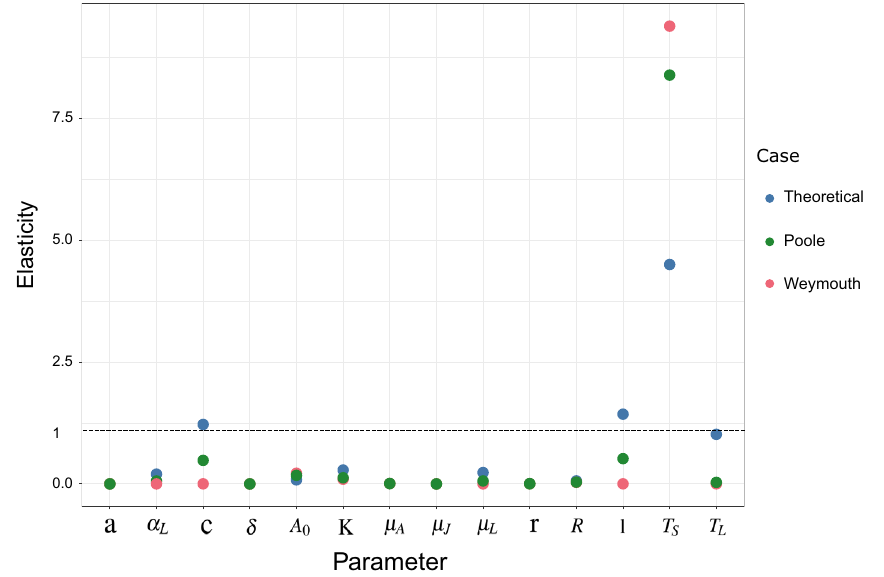
Figure 6. Elasticity analysis of model applied to the theoretical scenario (blue points) under favorable temperature conditions for annual spawning, and case studies Weymouth (pink points) and Poole (green points) under observed conditions for parameters defined in Table 1. The elasticity value reflects the proportional change in the adult oyster population density resulting from a 1% change in the parameter value and is